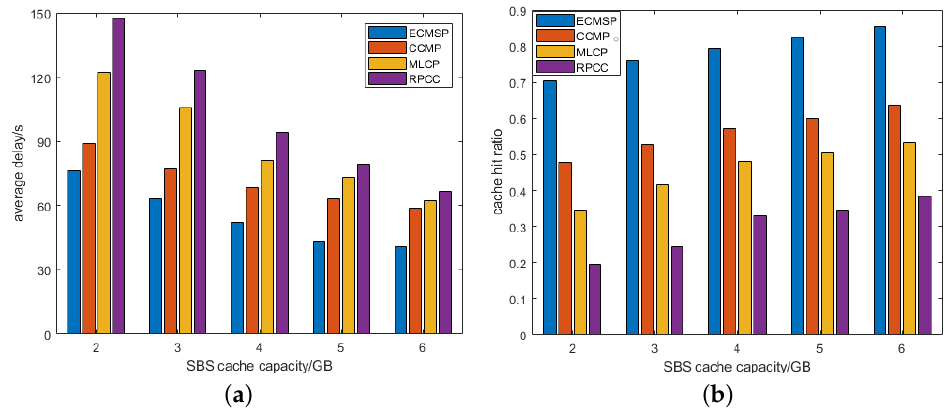
Figure 9. The impact of changing the cache capacity of SBSs on cache performance: ( a ) average delay; ( b ) cache hit